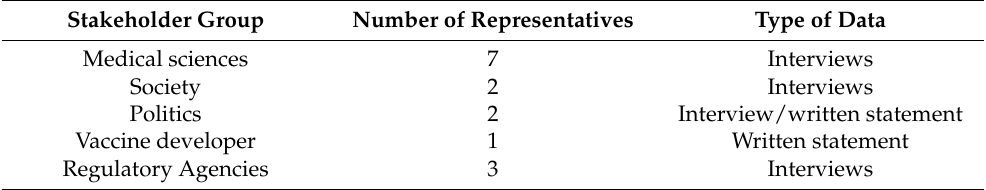
Table 2. Stakeholder groups